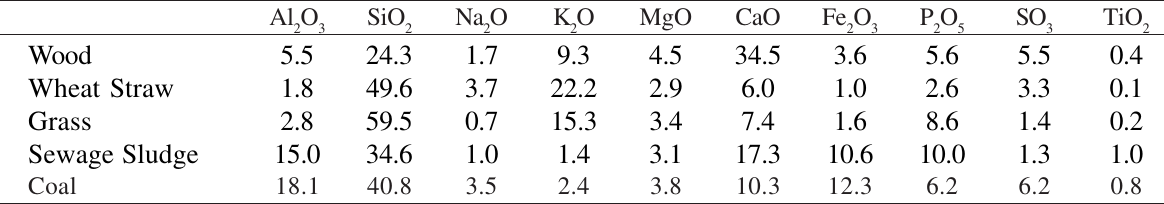
Table 2. Ash analyses of biomass and fossil